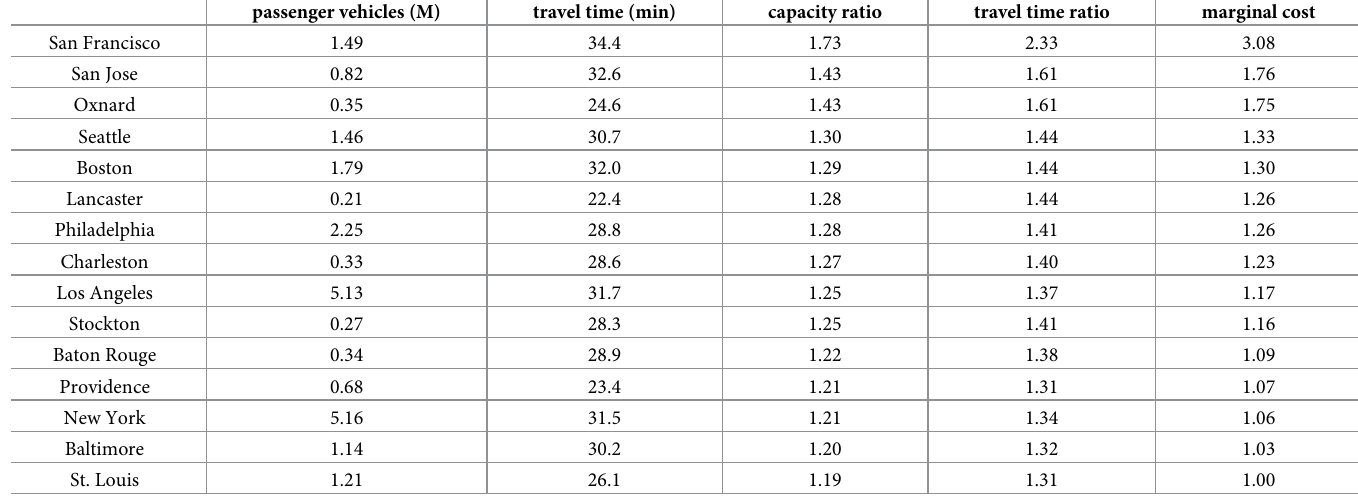
Table 2. Marginal cost of additional users, quantifying the sensitivity of the travel time ratio with respect to changes in the capacity ratio. Metro areas with the top 15 marginal costs are shown. passenger vehicles (M)